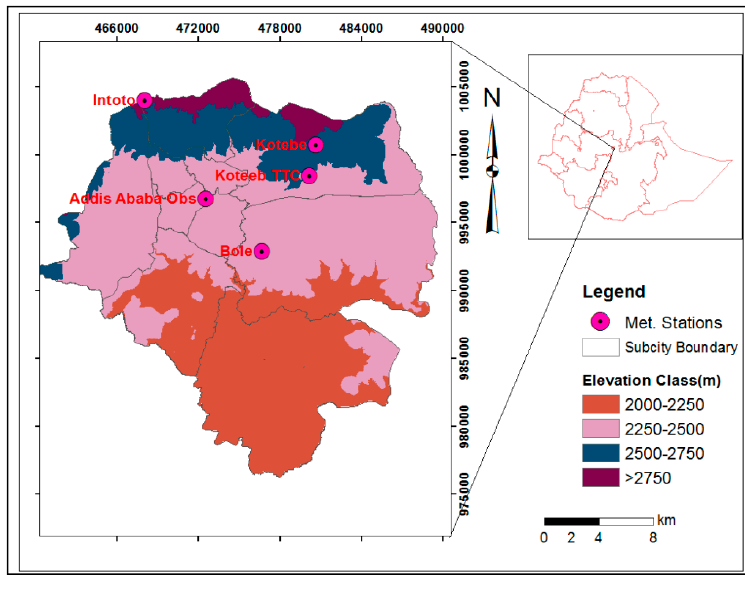
Figure 1. Study area.